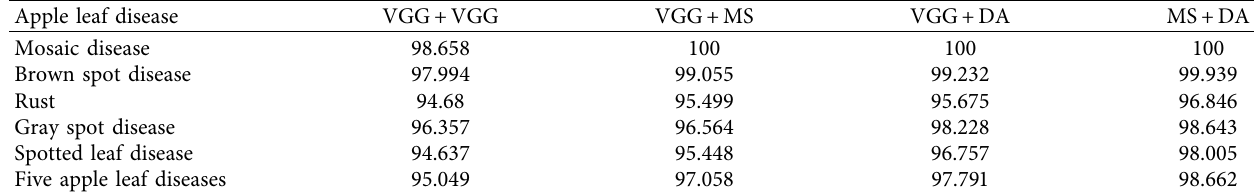
Table 11: Ablation experiments.